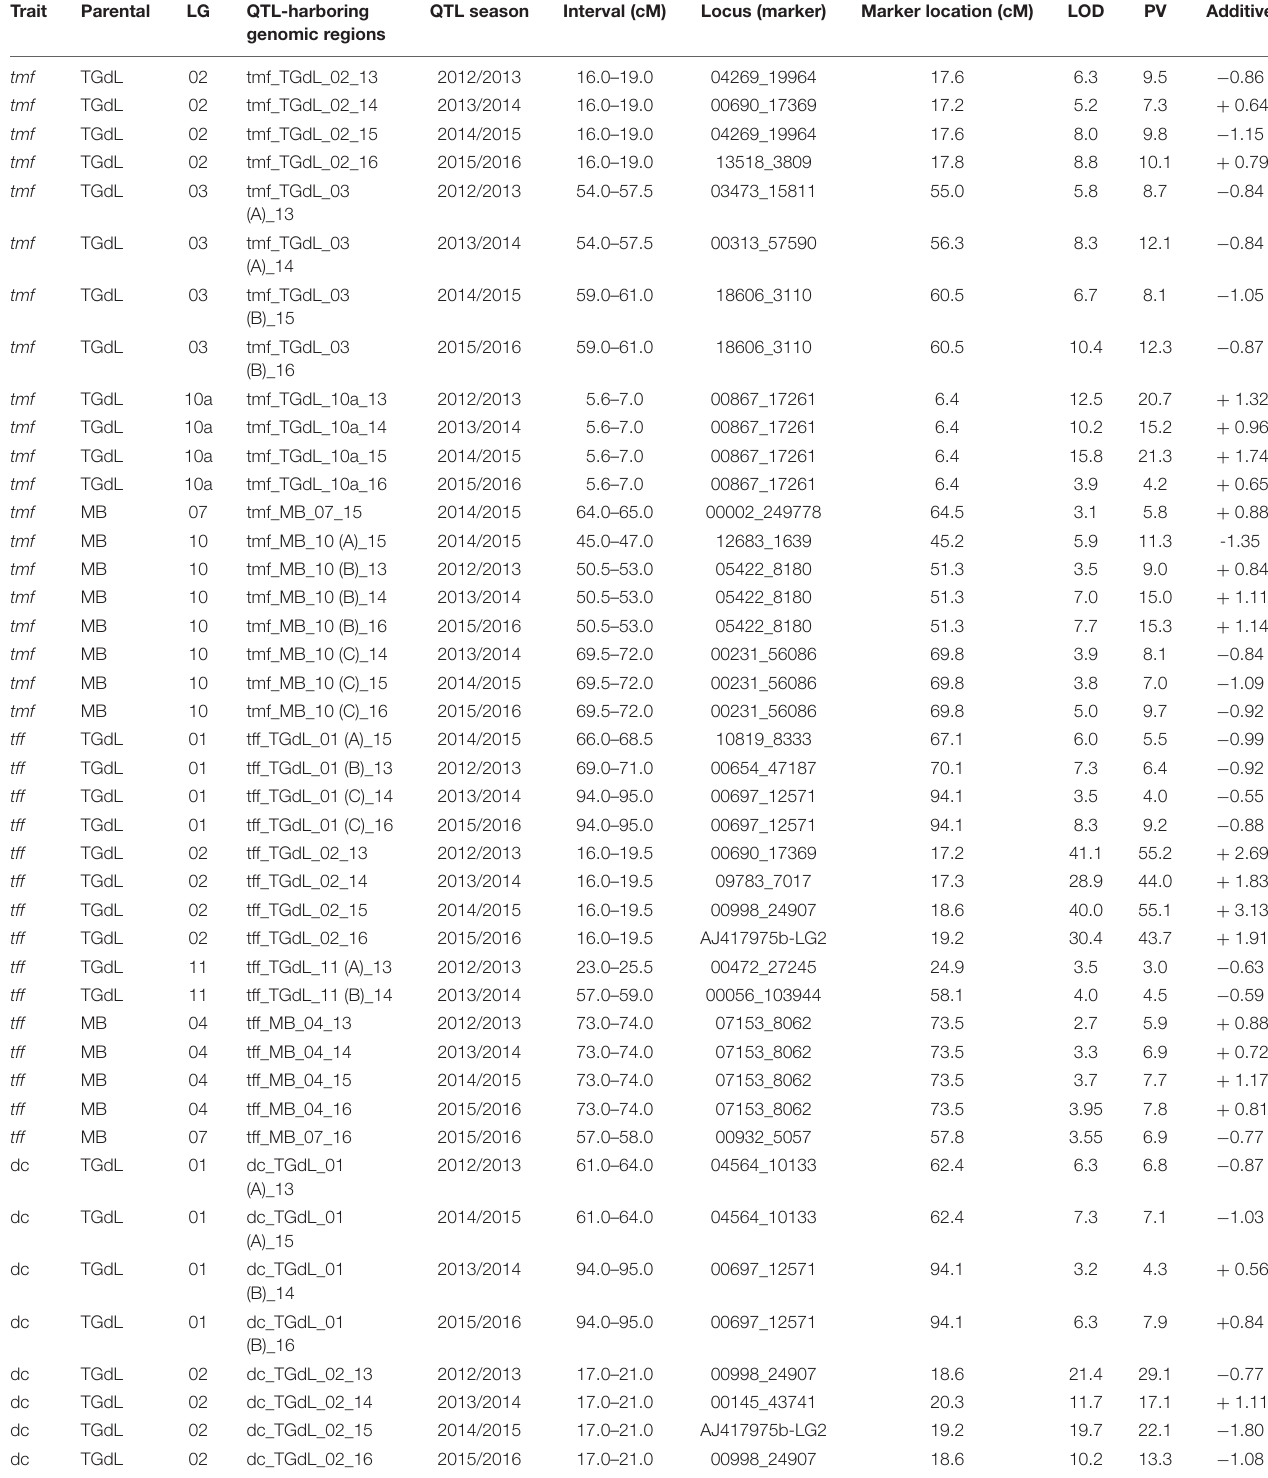
TABLE 3 | Time of male flowering ( tmf ), time of female flowering ( tff ), dichogamy ( dc ), and time of nut maturity ( tnm ) QTL identified using either the TGdL or the MB linkage map. Trait Parental LG QTL-harboring genomic